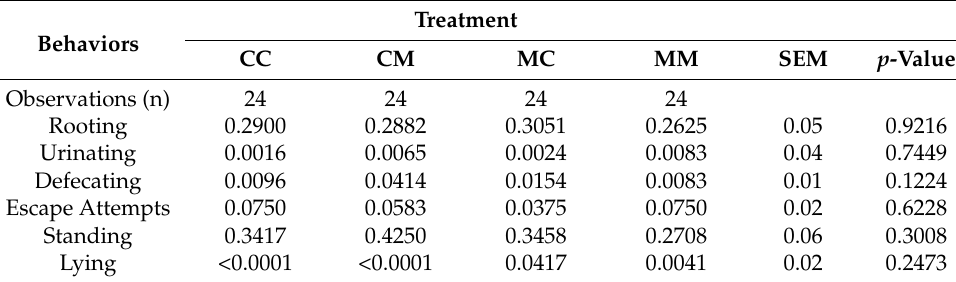
Table 1. Effect of auditory environmental enrichment on the mean proportion of behaviors of piglets distributed in the CC treatments: control-control; CM: control-music; MC: music-control; MM: music-music, during the novel arena test.